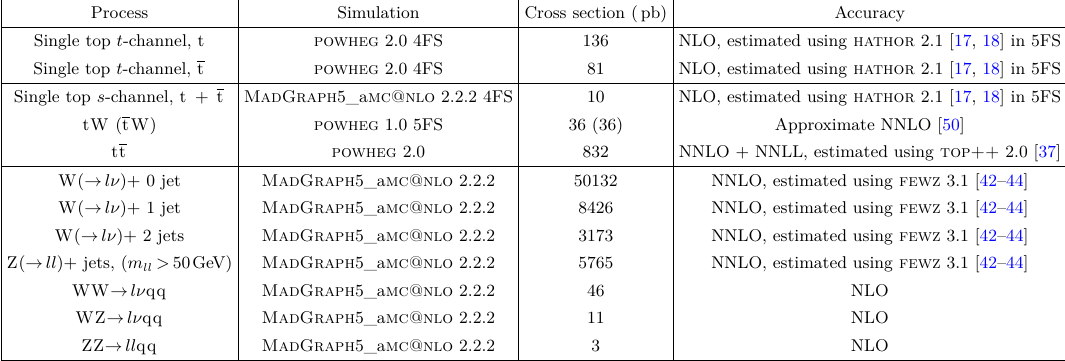
Table 1 . Summary of signal and background simulations discussed in section 3 with their respective cross